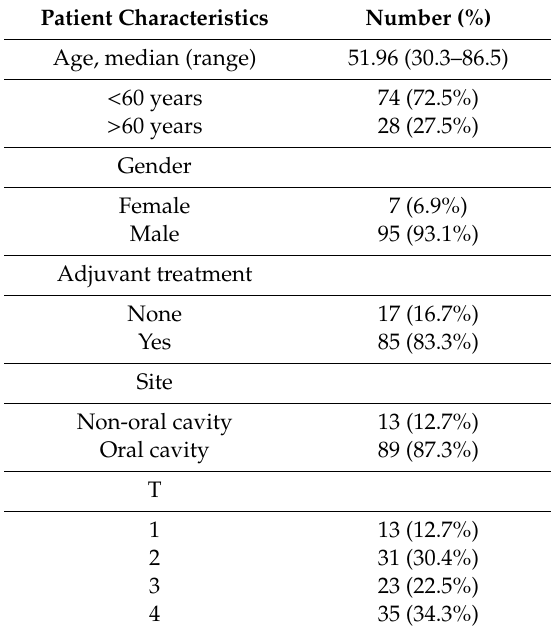
Table 1. Characteristics of patients ( n =